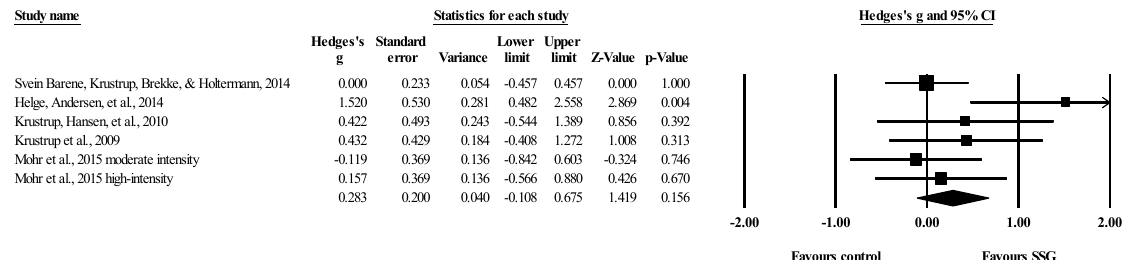
Figure 5. Funnel plot for changes in total body bone mineral density in untrained adults after a training program based on soccer small-sided games compared to an active control condition. White circles: observed studies. Eight studies provided data for total body BMD, involving eight experimental groups (pooled n = 151). Results showed a small effect of SSGs on total body BMD (ES = 0.23; 95% CI = − 0.01 to 0.46; p = 0.057; I 2 = 70.2%; Egger’s test p = 0.009; Figure 6). After the Trim and Fill method was applied, the adjusted values remained equal to the observed values. For the assessment of publication bias, a funnel plot is presented in Figure 7. Figure 6. Forest plot of within-group changes in total body bone mineral density (BMD) in untrained adults after a training program based on soccer small-sided games. Values shown are effect sizes (Hedges’s g) with 95% confidence intervals (CI). The size of the plotted squares reflects the statistical weight of each study. The black diamond reflects the overall result.